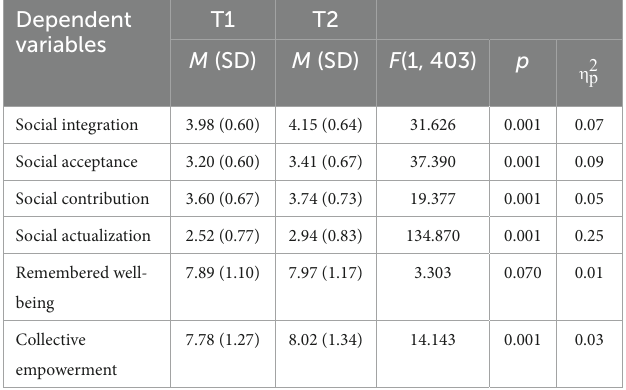
TABLE 1 Results of repeated measures of dependent variables in T1 and T2. Dependent